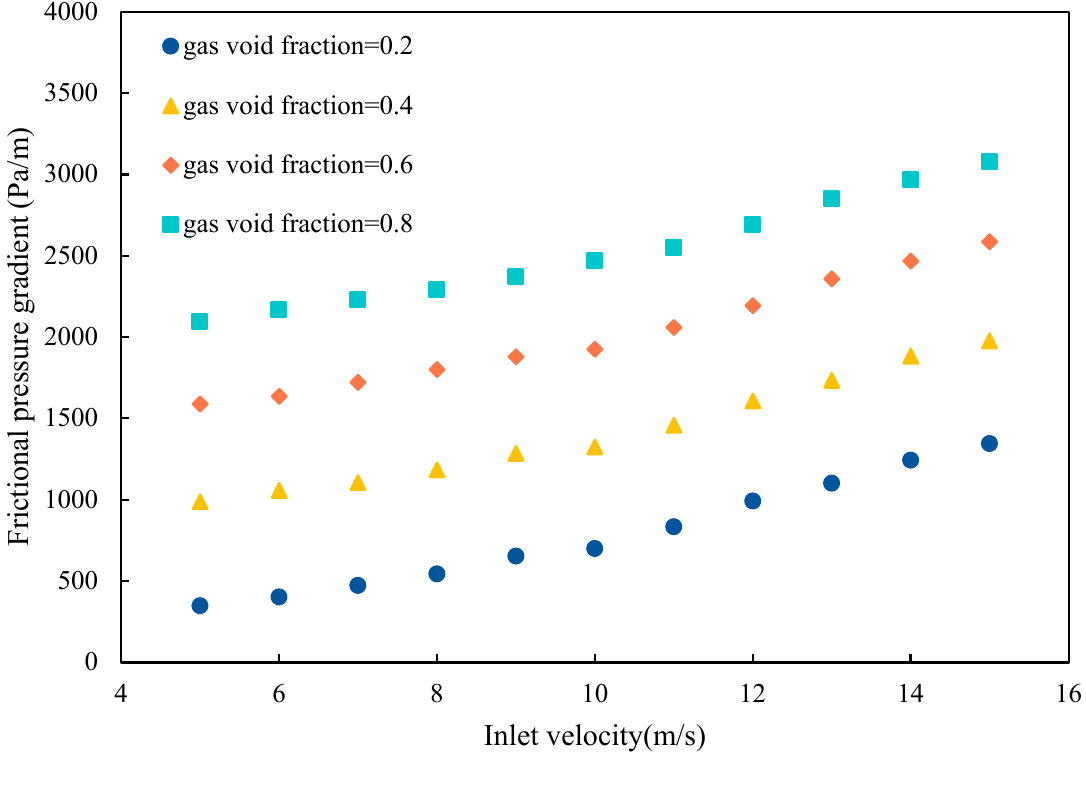
the hydrodynamic characteristics of CT. A frictional pressure drop model is expected to establish what the influence of tubing roughness and curvature ratio are.